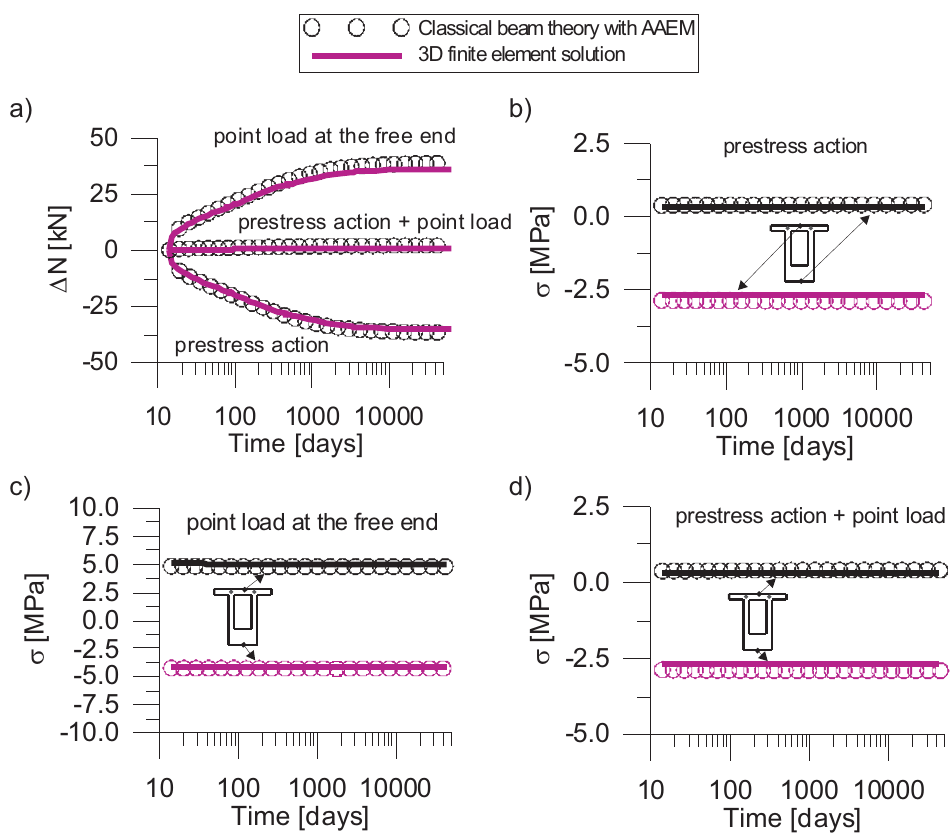
Figure 10. ( a ) Evolution of the force in the prestress steel tendon for different loading conditions; ( b – d ) evolution of the normal stresses in the middle-span cross-section for the prestress action only, the point load only, and the both of them, respectively.